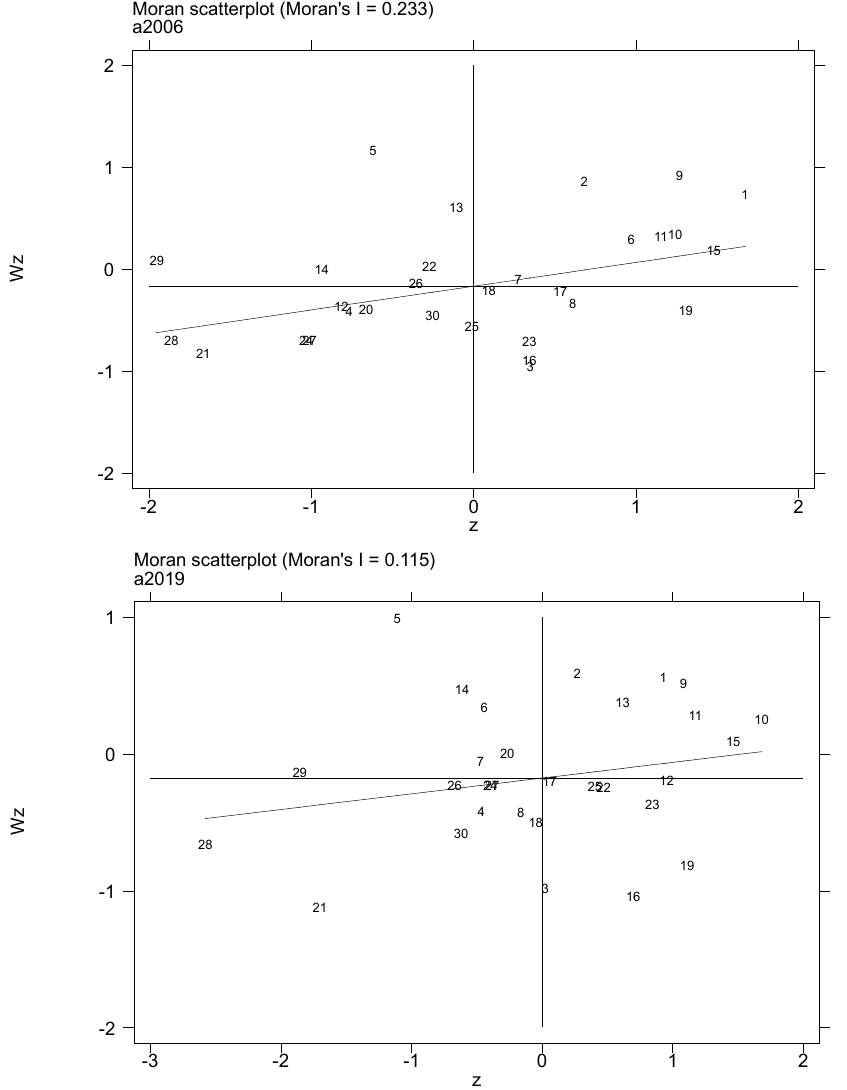
Figure 9. Moran scatter plot of agricultural technology research and development in 2006 and 2019.